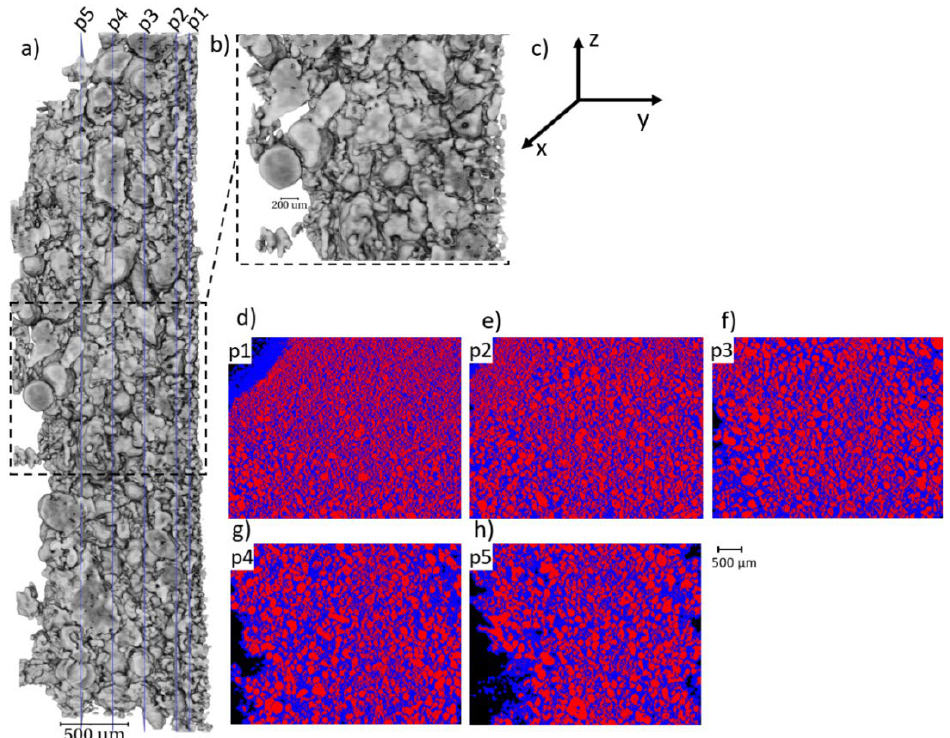
Figure 9. ( a ) A 3D-rendered volume of the investigated specimen with ( b ) a detailed insight of a selected part. ( c ) The orientation of the coordination system. ( d – h ) Presentation of the selected segments in the sample-selected, segmented xz projections along the y -axis (specimen thickness), shown from the left to the right side/edge of the specimen. For the purpose of clarity, xy projections are labelled as p1, p2, p3, p4, and p5, and they are indicated by thin violet lines in the 3D-rendered volume image. The red, blue, and black colors in xy projections represent grains, pores, and spaces out of the specimen.